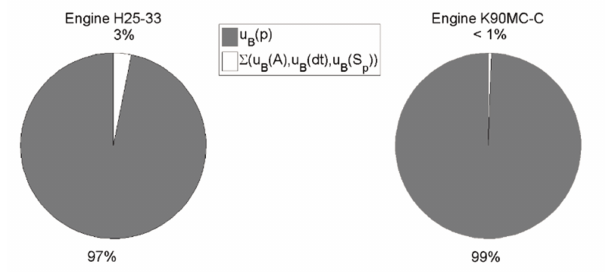
Fig. 1. Distribution of the indicated power uncertainties (method A) for marine engines – medium speed H25-33 and slow speed K90MC-C; – clock time interval uncertainty; u $ (cid:22)dt(cid:24)